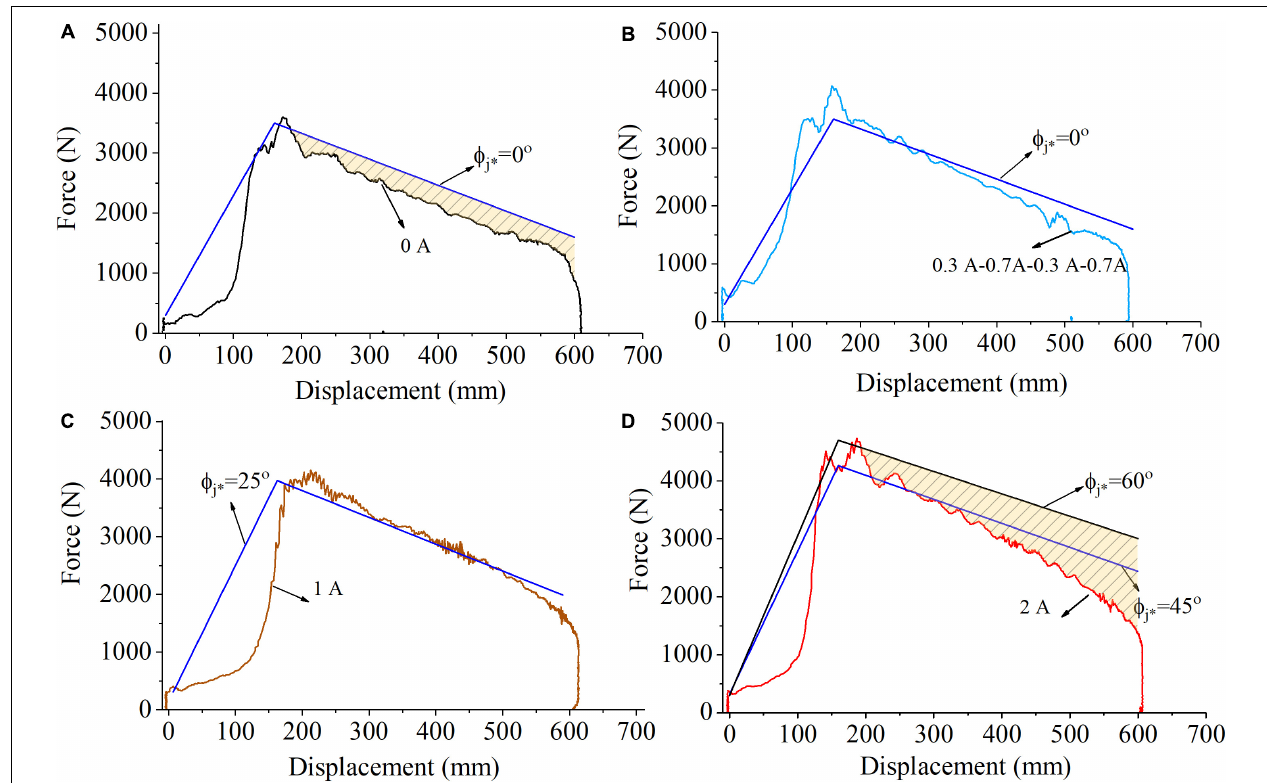
FIGURE 10 | Comparison of measured and theoretical F-S curve of field gun. (A) I = 0A, (B) I = 0.3 A-0.7 A-0.3 A-0.7 A, (C) I = 1 A, and (D) I = 2 A.